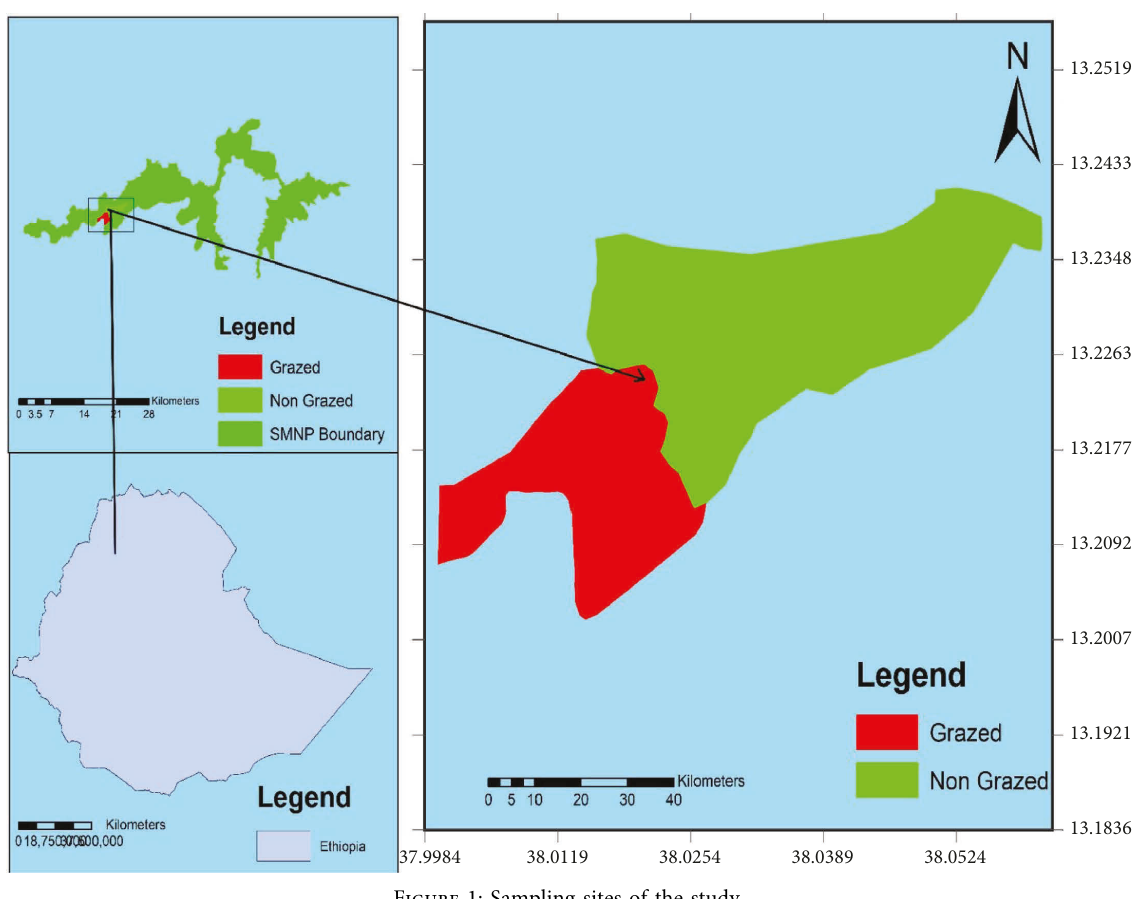
Figure 1: Sampling sites of the